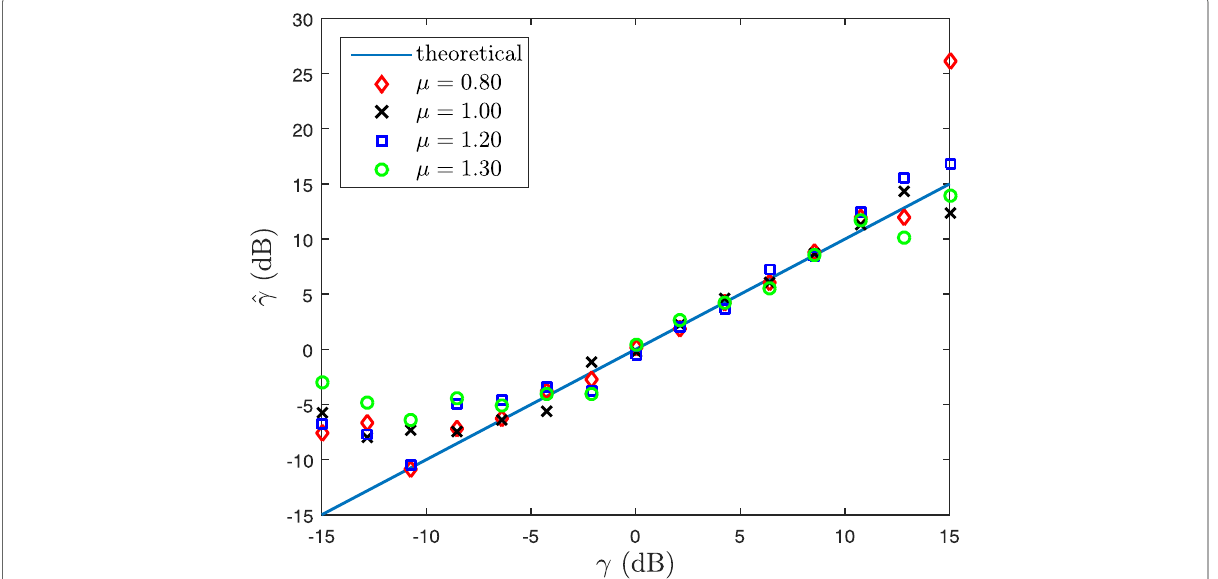
Fig. 4 Mean of the estimate ˆ γ as a function of SNR in dB for fading η − μ with η = 0.1, different values of μ , N = 5 × 10 4 and 64-QAM